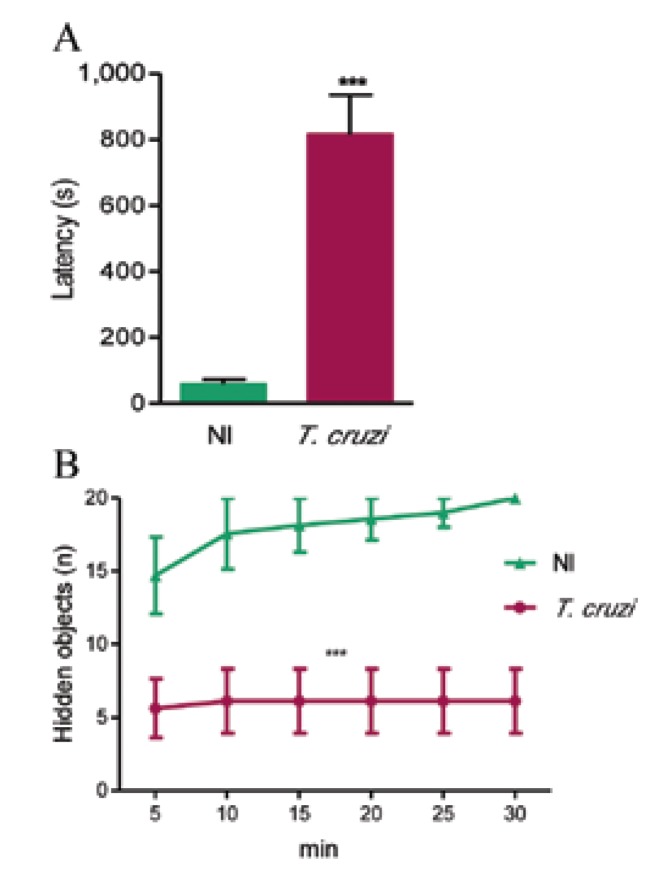
: anxiety behaviour in C57BL/6 mice during infection withTry-
panosoma cruzi. Animals were infected with 100 trypomastigotes of
the Colombian strain and subjected to the marble burying test. The latency and
the quantification of the number of hidden balls were analysed in a 30 min
period. Data represent means ± standard deviation. The groups were composed of
seven-16 mice. Data are representative of three independent experiments.
Asterisks mean p < 0.001. NI: noninfected.